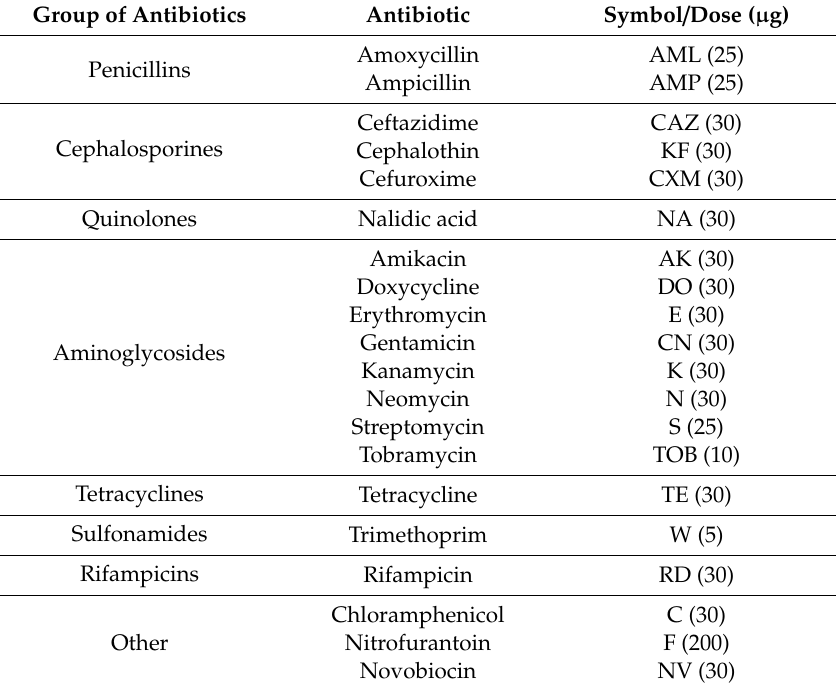
Table 2. Antibiotics and their doses used in multi-antibiotic resistance test (MAR). Group of